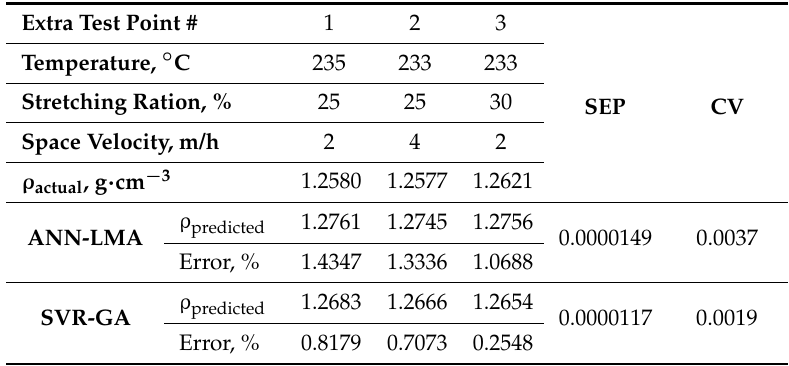
Table 3. Validation set comparison of the two models.